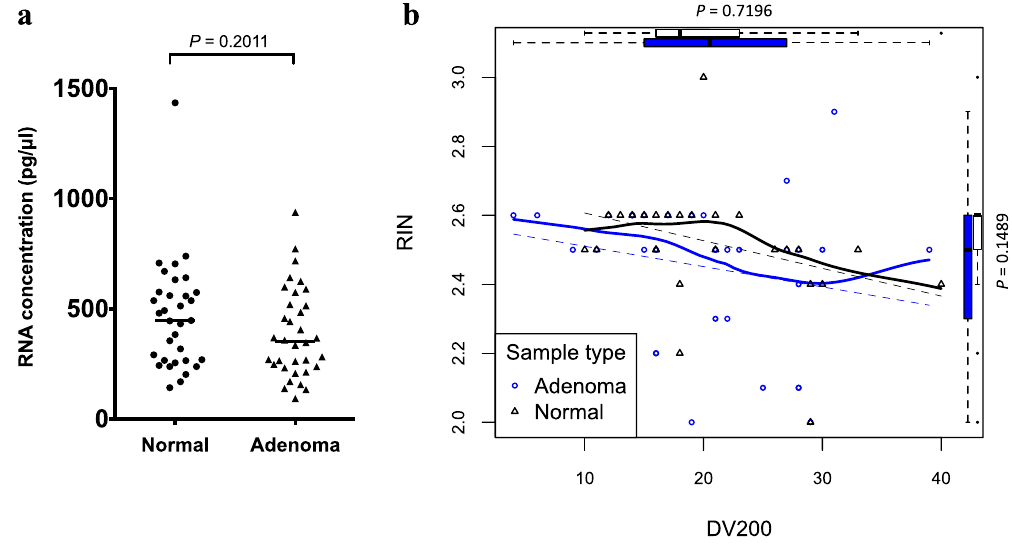
Figure 1. Plasma total RNA concentration and quality. The plasma total RNA (a) concentration and two parameters (b) RIN and DV 200 for describing RNA quality had no significant difference in normal and adenoma plasma samples ( P > 0.05, Mann-Whitney test). The similar relationships between RIN and DV 200 in normal and colorectal adenoma plasma were observed. The solid line in (b) represented the best-fit curve calculated by Lowess function, and the dotted line represented the linear-fit result. The box and whisker plots at the top and the right side of (b) demonstrated the value distribution of DV 200 and RIN,